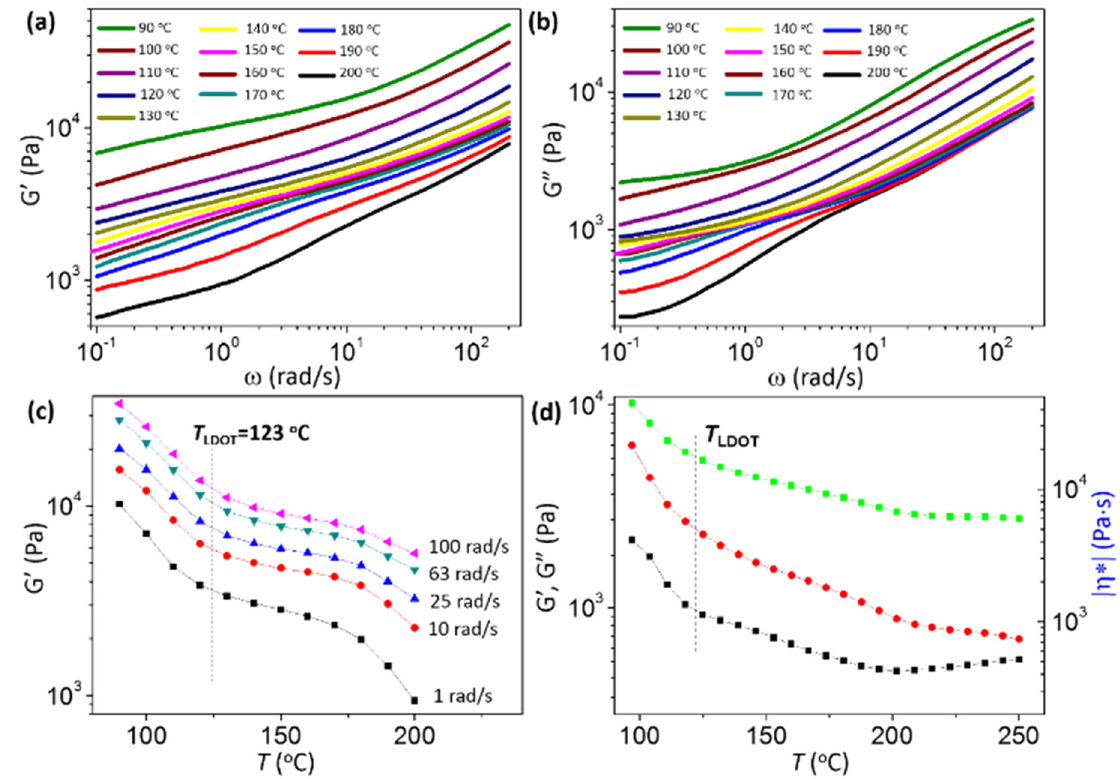
Figure 4: ( a ) Storage modulus ( G ′ ) and ( b ) loss modulus ( G ″ ) versus angular frequency ( ω ) from dynamic oscillation at a fi xed temperature range from 100°C to 210°C with the interval of temperature at 10°C for ( S 15.4 - 0.28 - B 34.3 ) 3 , ( c ) isochronal plots of G ′ versus temperature ( T ) for ( S 15.4 - 0.28 - B 34.3 ) 3 , ( d ) temperature dependence of the storage modulus ( G ′ ) , loss modulus ( G ″ ) , and complex viscosity (| η * |) obtained at the strain amplitude 1% and a signal angular frequency 1 rad · s − 1 during the cooling of ( S 15.4 - 0.28 - B 34.3 ) 3